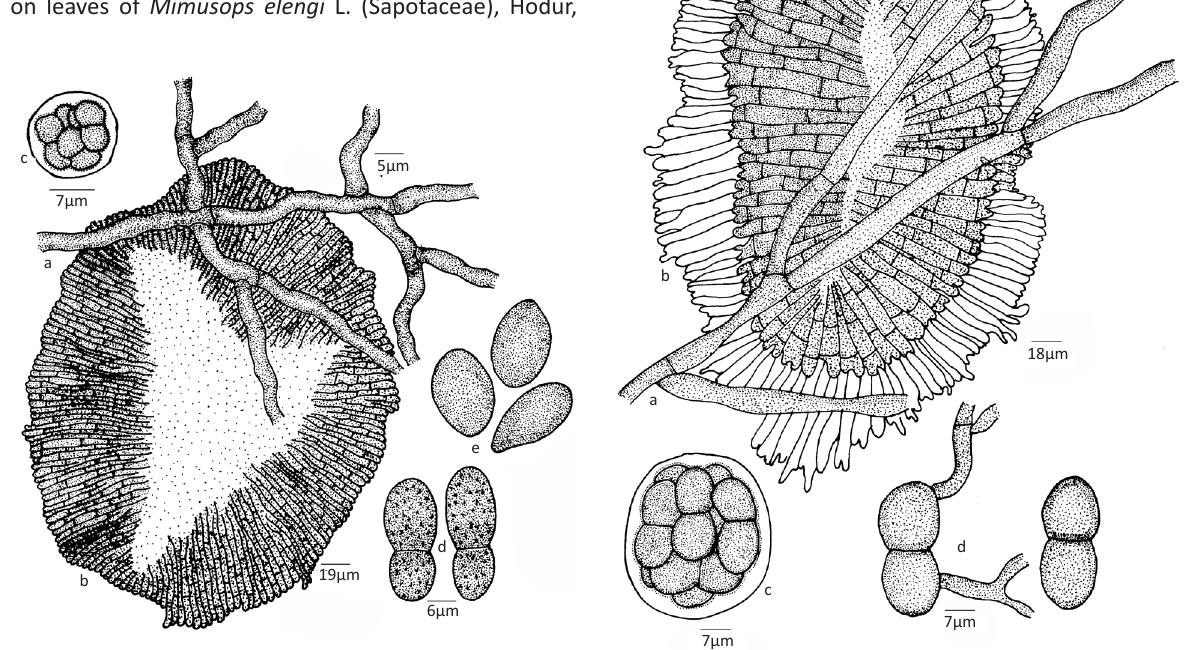
Figure 10. Prillieuxina humboltiae sp. nov. a - Mycelium; b - Thyriothecium; c - Ascus; d - Ascospores; Figure 11. Echinodella mimusopsidis sp. nov.